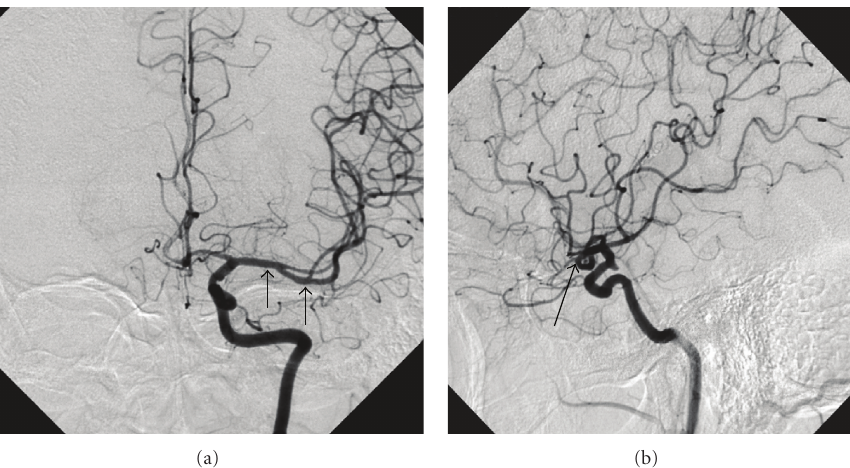
Figure 7: Follow-up angiograms—antero-posterior (a) and lateral views (b) 6 months later. The stented segment of MCA is indicated with